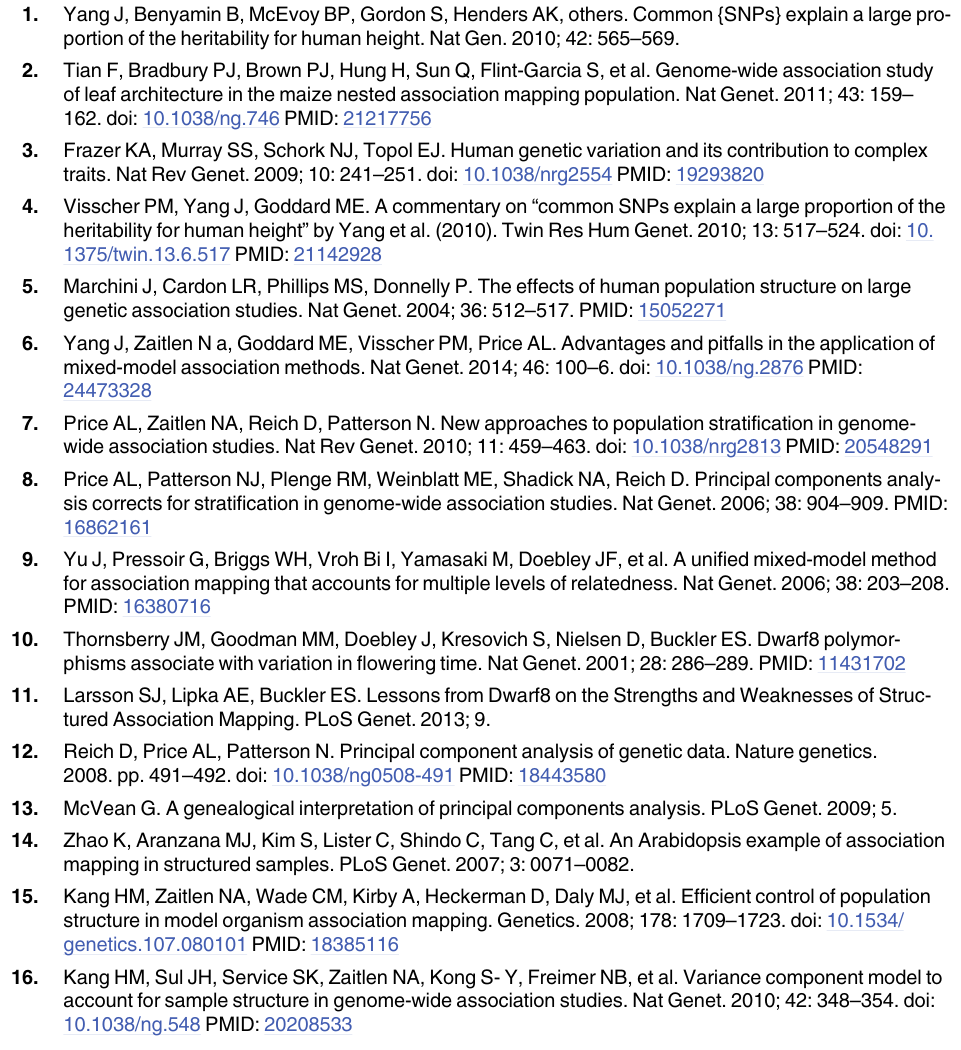
S11 Table. Software versions and codes for building kinship matrices and association